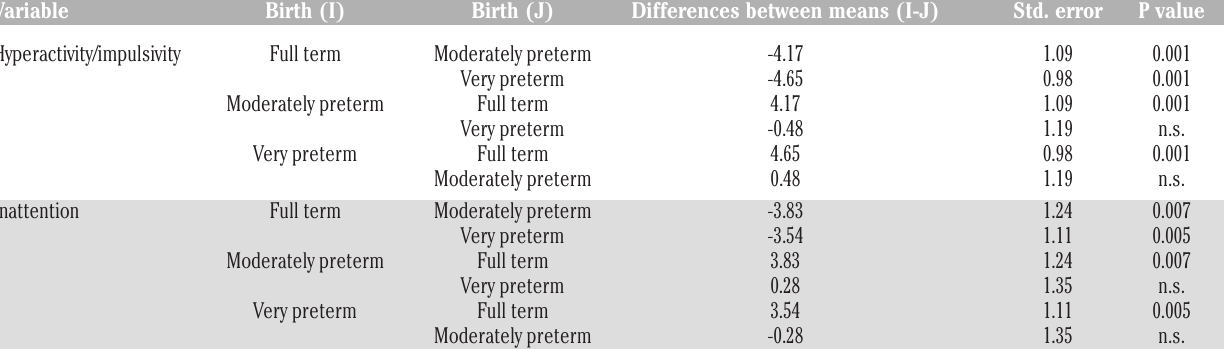
Table 3. Differences between groups for birth (full term, moderately preterm, very preterm): Tukey's HSD Test (Honestly Significant Difference). Variable Birth (I) Birth (J) Differences between means (I-J) Std. error P value